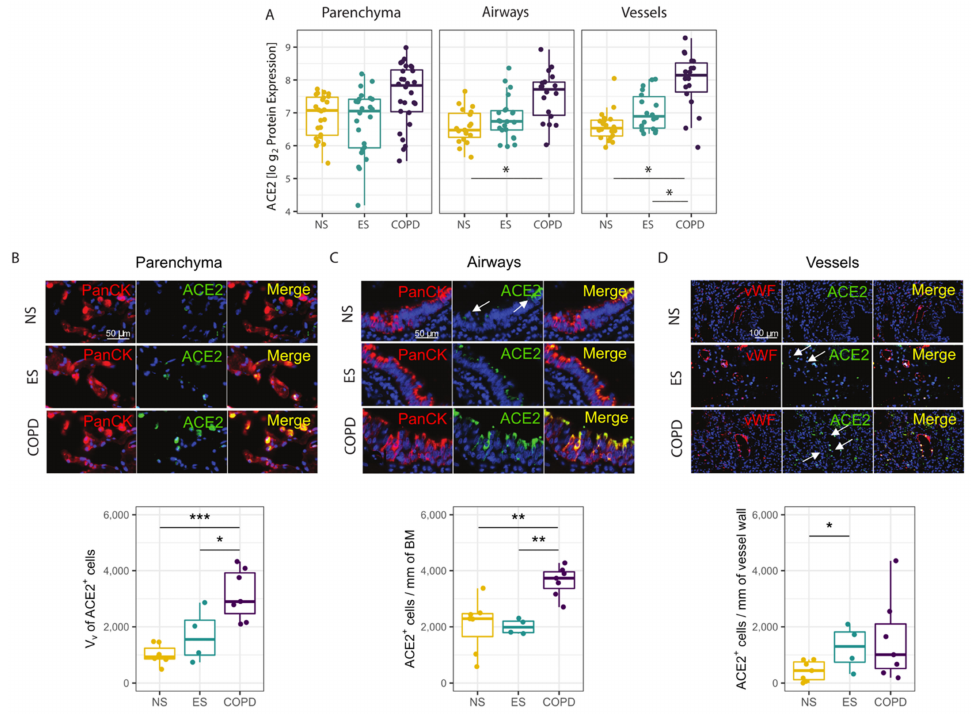
Figure 3. ACE2 spatial proteomic expression: ( A ) ACE2 protein expression levels were quantified in the parenchyma, airway, and vessel ROIs in formalin-fixed paraffin embedded (FFPE) lung